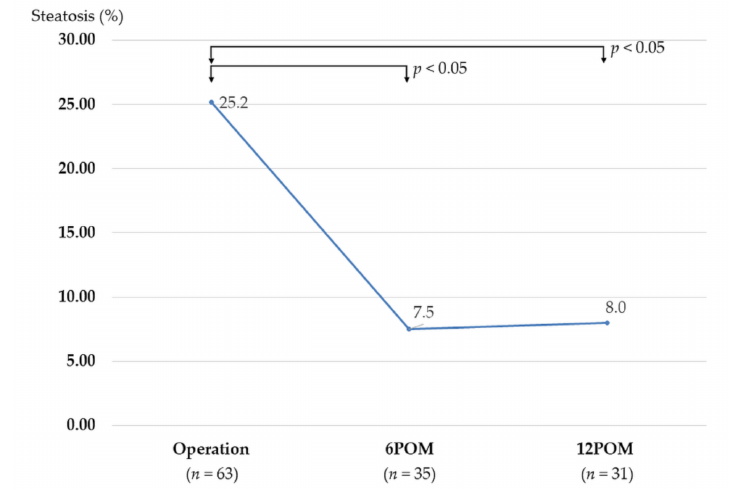
Figure 7. Changes in the percentages of steatosis evaluated by protocol liver biopsy. Abbreviations: 6POM, 6 months after LSG; 12POM, 12 months after LSG.